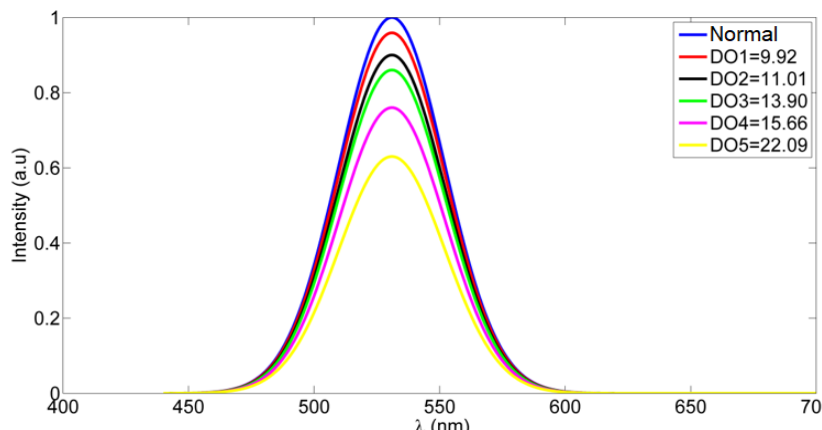
Figure 3. Emission intensity quenching of in-situ adding of Au NPs at different concentrations of dissolved oxygen (DO). The word “Normal” means gold-ceria nanoparticles in normal distilled water with no further added DO concentration, where the measured DO was 7.8 mg/L. All mentioned concentrations of DO in the legend are in mg/L.